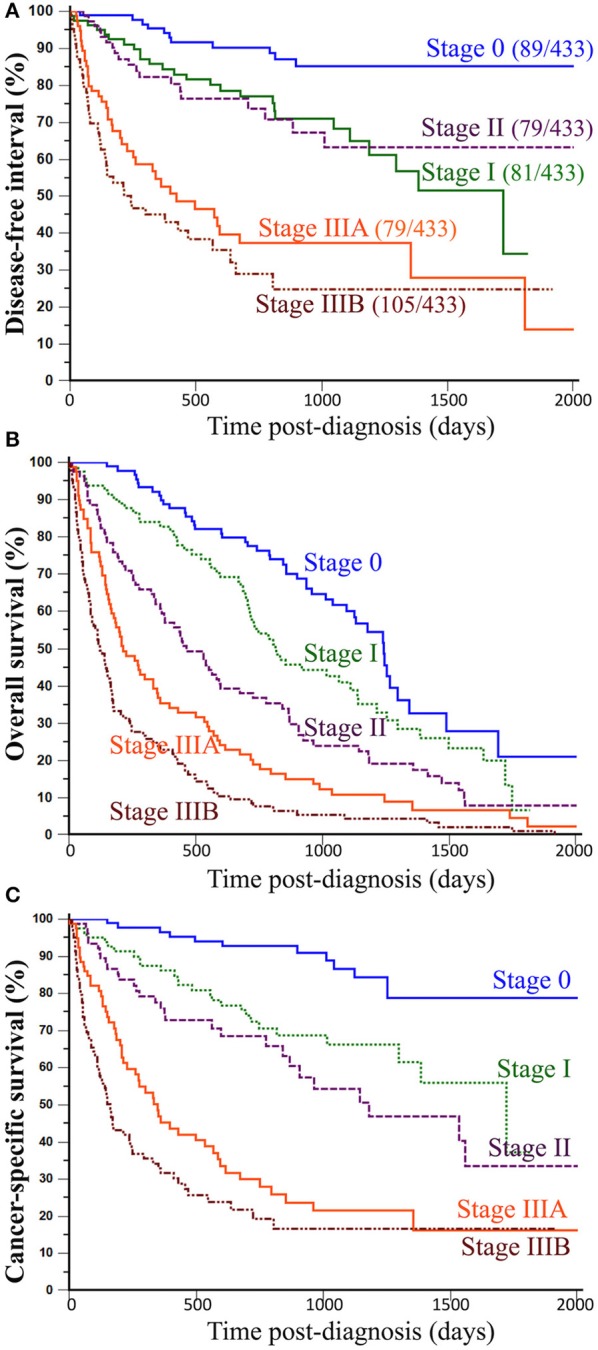
Association between histological stages of CMCs and outcomes of canine patients. (A) Disease-free interval. The probability of locoregional recurrence and/or distant metastasis significantly increased from stage 0 to stage IIIB CMCs, however without significant differences between stage I and stage II CMCs. (B) Overall survival. All-cause mortality of female dogs with mammary carcinoma significantly increased with increasing histological stage at presentation. (C) Cancer-specific survival. The probability of dying from cancer significantly increased with histological stage. Kaplan-Meier curves. See Table 4 for corresponding hazard ratios and p-values.